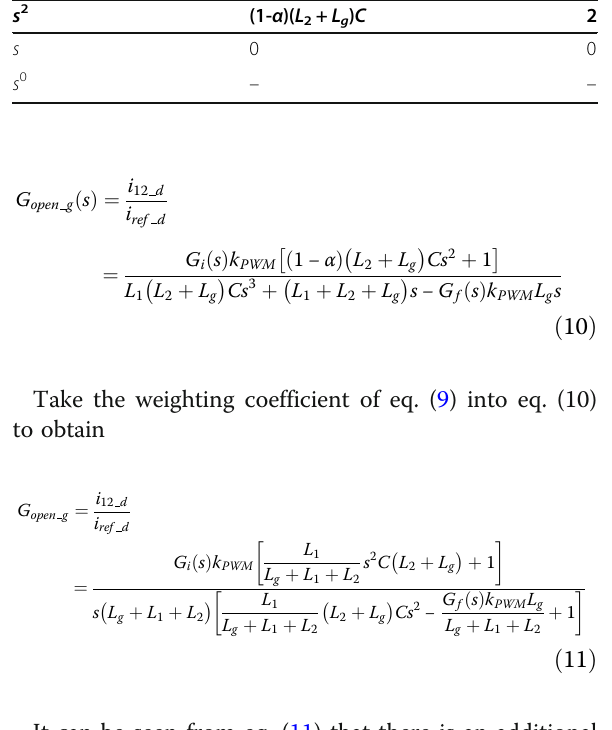
Table 2 Closed-loop transfer function Rolls decision table